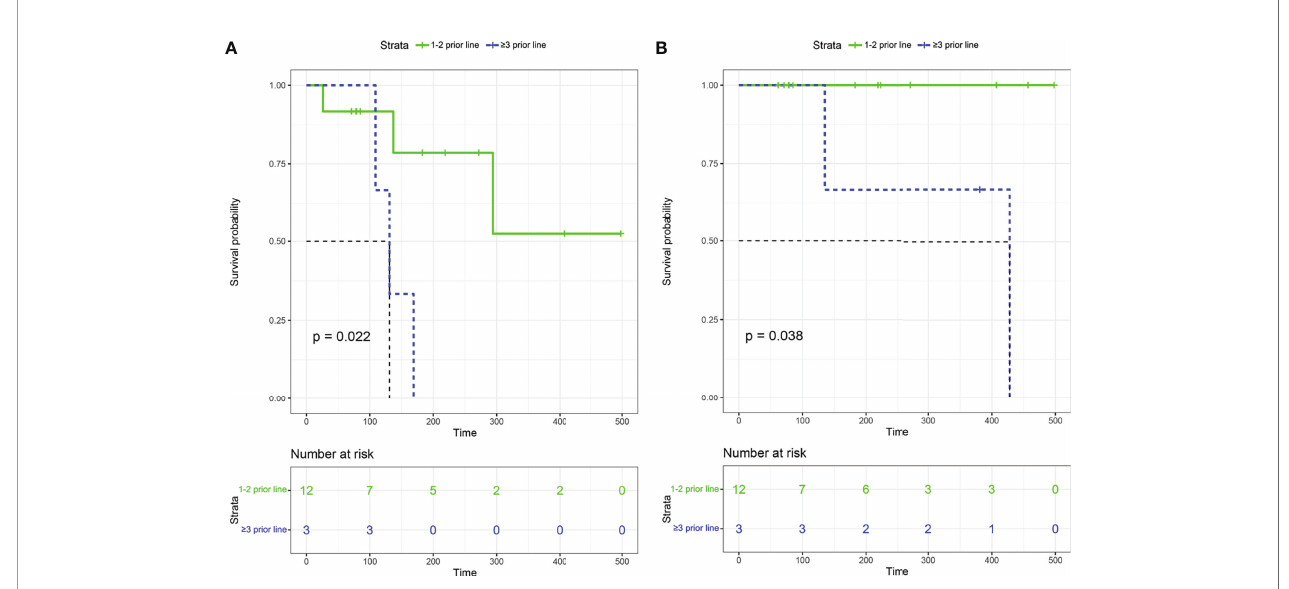
FIGURE 2 | Kaplan – Meier survival curves among patients with 1-2 prior lines and ≥ 3 prior lines. (A) Progression-free survival. (B) Overall